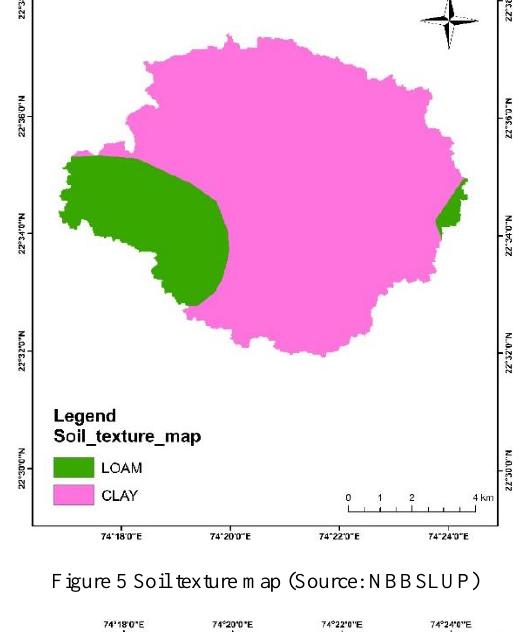
Figure 5 Soil texture map (Source: NBBSLUP)